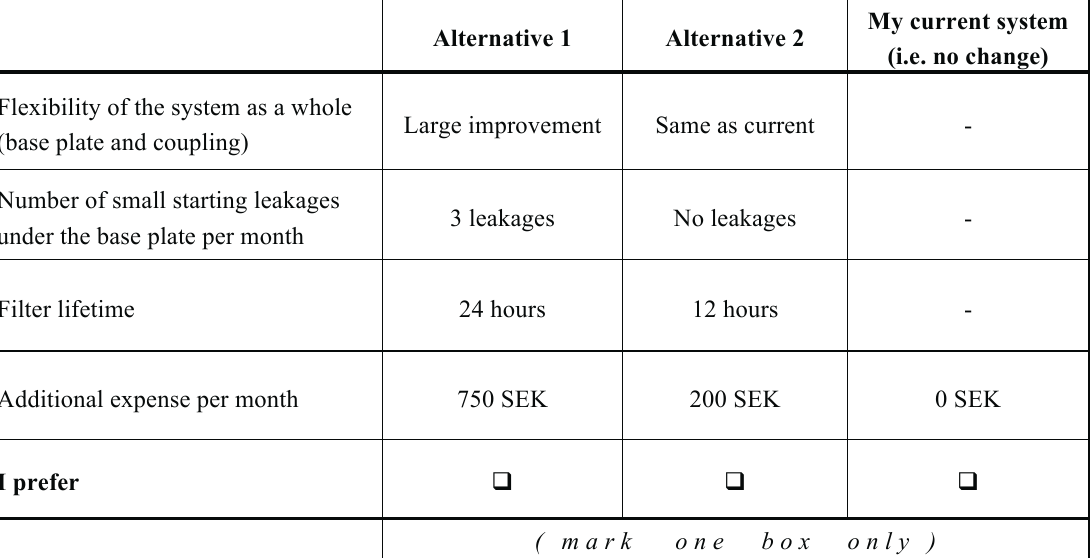
Figure 1: Choice set example My current system Alternative 1 Alternative 2 (i.e. no change) Flexibility of the system as a whole Large improvement Same as current - (base plate and coupling) Number of small starting leakages 3 leakages No leakages - under the base plate per month Filter lifetime 24 hours 12 hours - Additional expense per month 750 SEK 200 SEK 0 SEK I